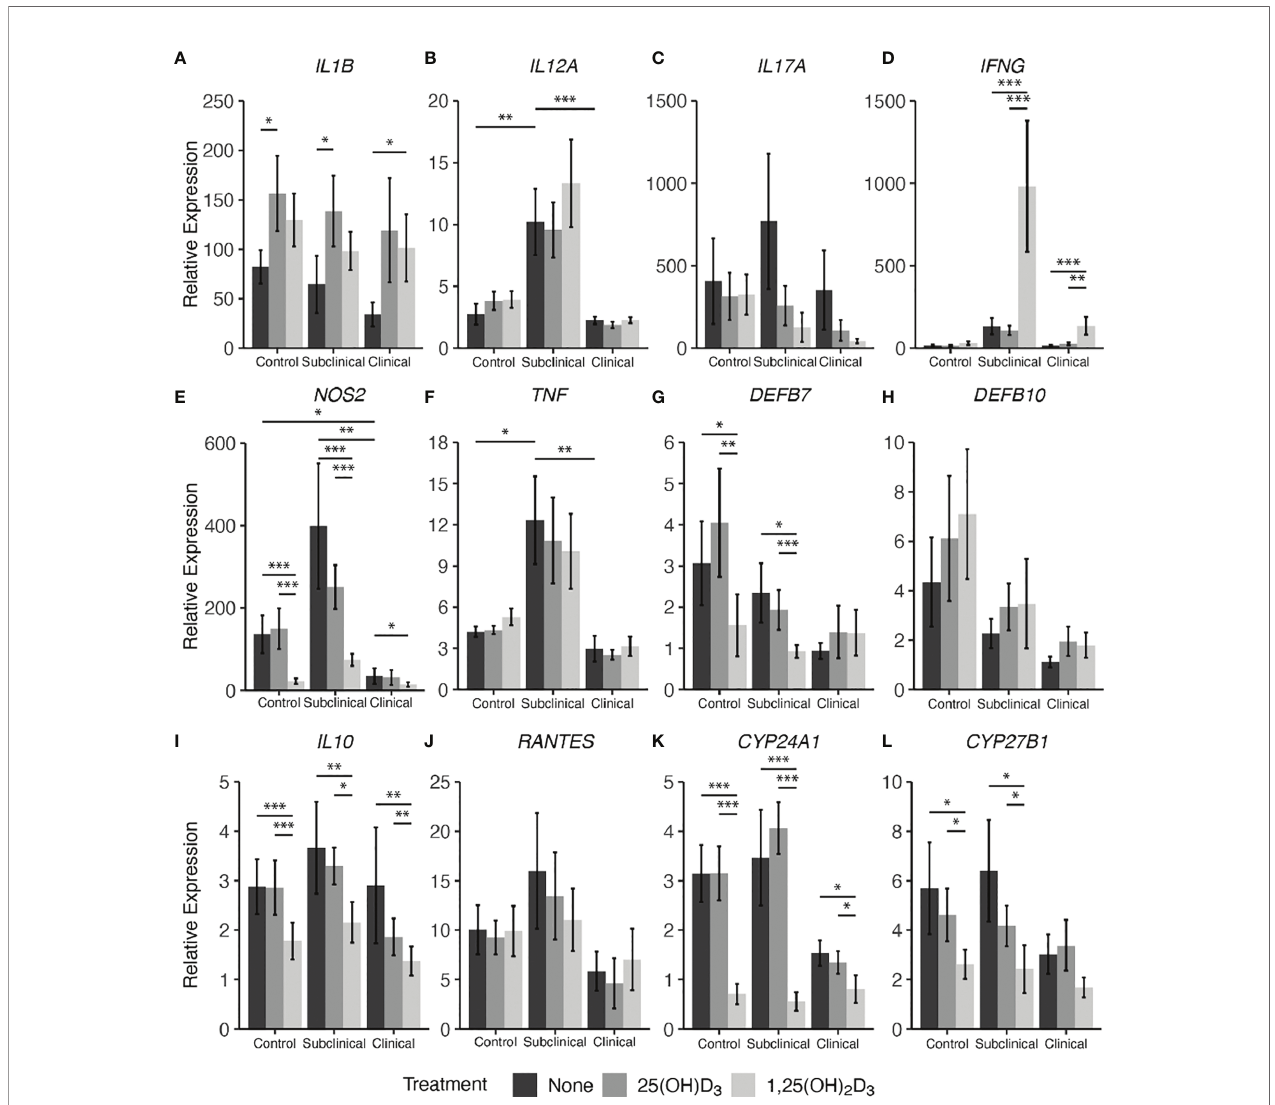
FIGURE 8 | Cytokine gene expression from monocyte-derived macrophages (MDMs) co-cultured with peripheral blood mononuclear cells (PBMCs) from naturally infected dairy cattle (clinical n=7, subclinical n=7) or noninfected controls (n=9). PBMCs isolated from whole blood were cultured 5-6 days to generate MDMs, pre- treated with vitamin D 3 as detailed in methods, then incubated 24 hrs with live MAP (10:1 MOI) ± 25(OH)D 3 or ± 1,25(OH) 2 D 3 . Extraction and puri fi cation of RNA was performed using Qiagen RNeasy Mini kits and was reverse transcribed with Superscript IV. Gene expression for (A) IL1B , (B) IL12A , (C) IL17A , (D) IFNG , (E) NOS2 , (F) TNF , (G) DEFB7 , (H) DEFB10 , (I) IL10 , (J) RANTES , (K) CYP24A1 , and (L) CYP27B1 were determined using TaqMan assays and was normalized to the eukaryotic 18S rRNA reference gene. Data were transformed using the 2 - DD Ct method and are presented as the mean relative gene expression (RQ) ± SE compared to each sample ’ s respective non-stimulated (NS) control. Statistics were performed on ΔΔ Ct values and signi fi cance levels are as follows: * < 0.05, ** < 0.01, *** <